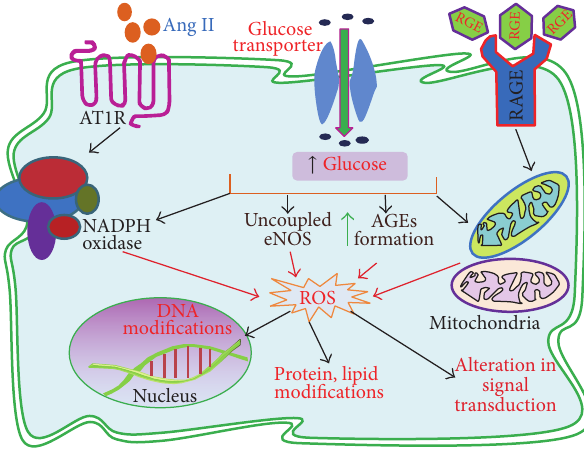
Figure 2: Sources of ROS generation and their impact on cellular components and signaling